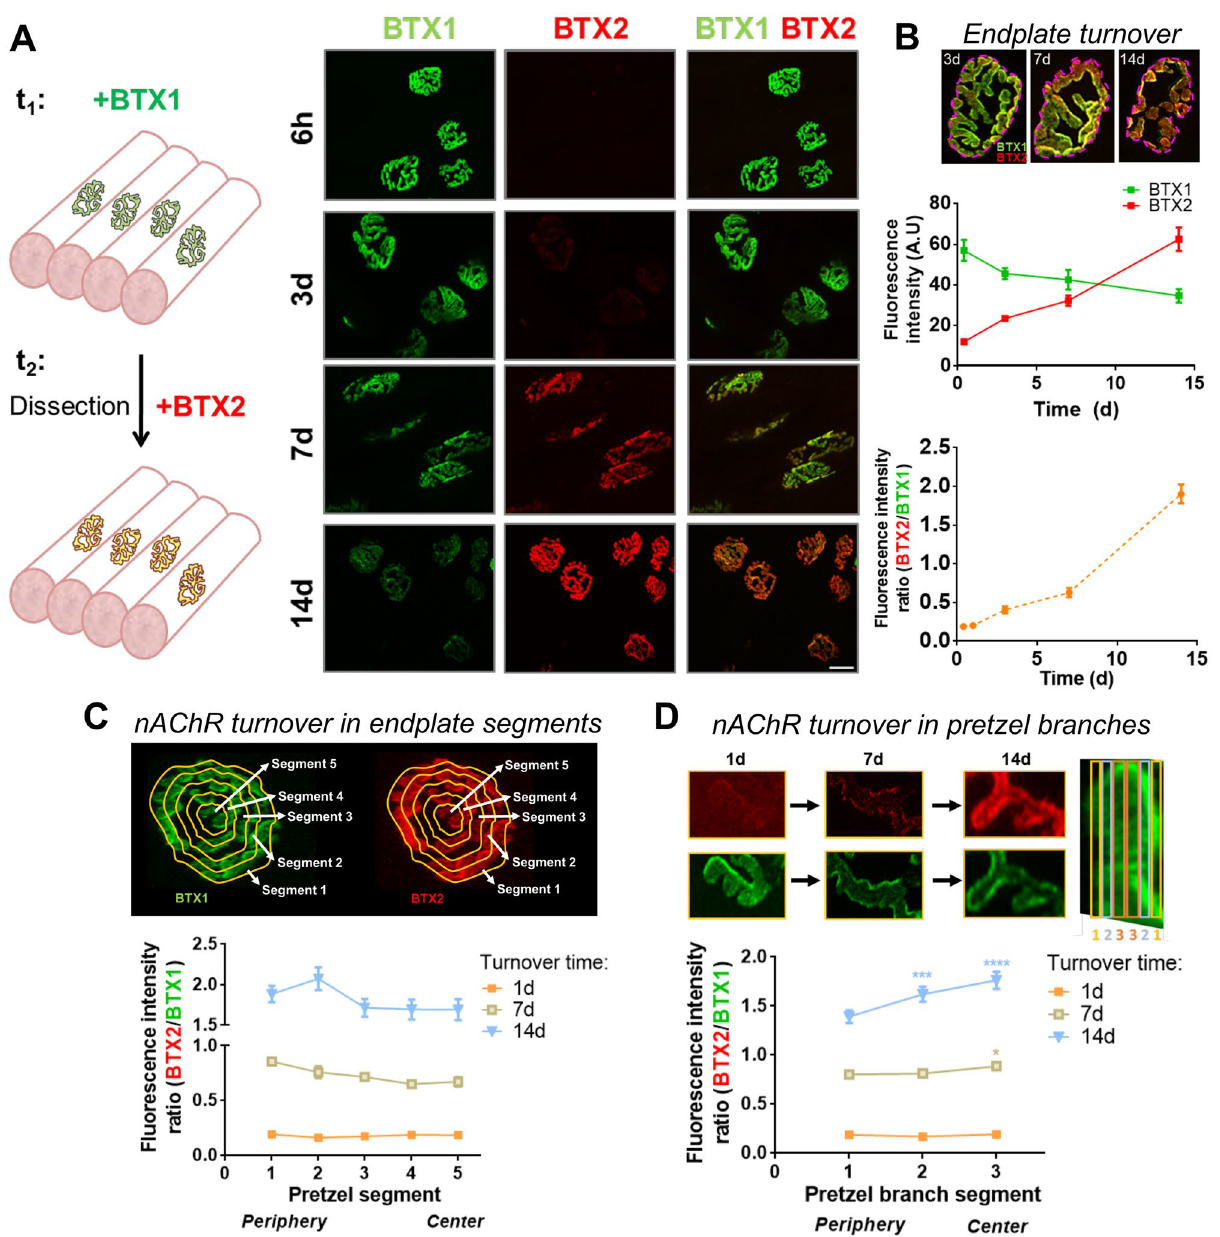
Figure 1. Compartmentalized analyses of nAChRs turnover in mature NMJs. ( A ) Experimental design used for the time-course analysis of nAChRs turnover. The pre-existing nAChRs pool was labelled with AlexaFluor488- BTX (BTX1) and after different time points, newly incorporated nAChRs were detected by AlexaFluor555- BTX (BTX2) staining. Pictures show representative confocal images of BTX1 and BTX2 staining at different time points ranging from 6h to 14d. Bar = 20 µm. ( B ) nAChRs turnover analyses in individual endplates were performed by quantifying BTX2 and BTX1 fluorescence intensity at different time points. nAChR turnover was evaluated using the BTX2/BTX1 fluorescence intensity ratio. Graphs represent mean values ± SEM of 25–50 NMJs for each time point. ( C ) Compartmentalized nAChRs turnover was determined by dividing each endplate in five concentric sections and fluorescence intensity of both BTX1 and BTX2 was measured. The graph represents mean values ± SEM for nAChRs turnover in each segment (1 to 5, from periphery to centre) from 10 endplates per animal. ( D ) nAChRs turnover within pretzel branches were analysed in three branches per pretzel located in the periphery, middle, and central region of the mature end-plate structure. Each branch was subsequently sectioned in peripheral (1, yellow), middle (2, gray), or centre (3, orange) segments. Fluorescence intensity ratios from BTX2/BTX1 were quantified and plotted. The graph represents the mean values ± SEM for each branch segment from 30 pretzel branches per animal. N = 2 (14d), or 3 (6h–7d). One-way ANOVA with subsequent Tukey’s multiple comparisons tests were performed at each point. **** p < 0.0001; *** p < 0.001; * p < 0.05 when middle (2) or centre (3) branch segments were compared to the peripheral (1)